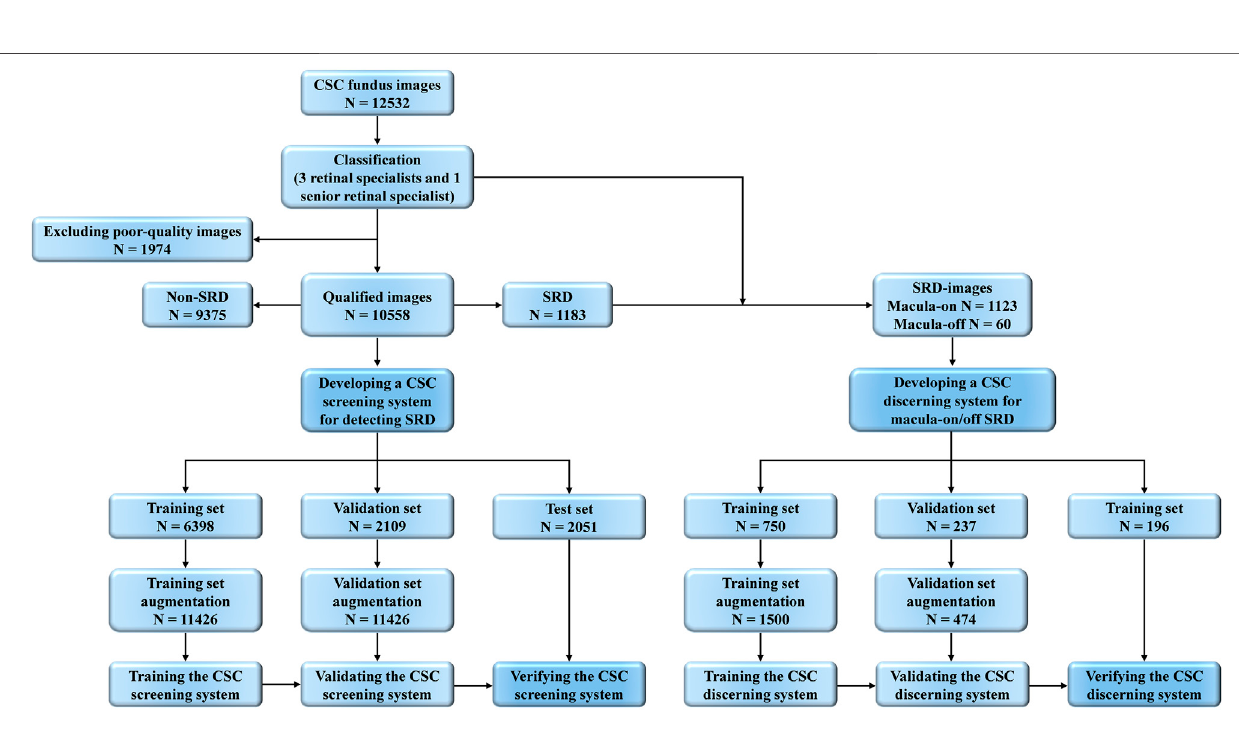
Frontiers in Bioengineering and Biotechnology |